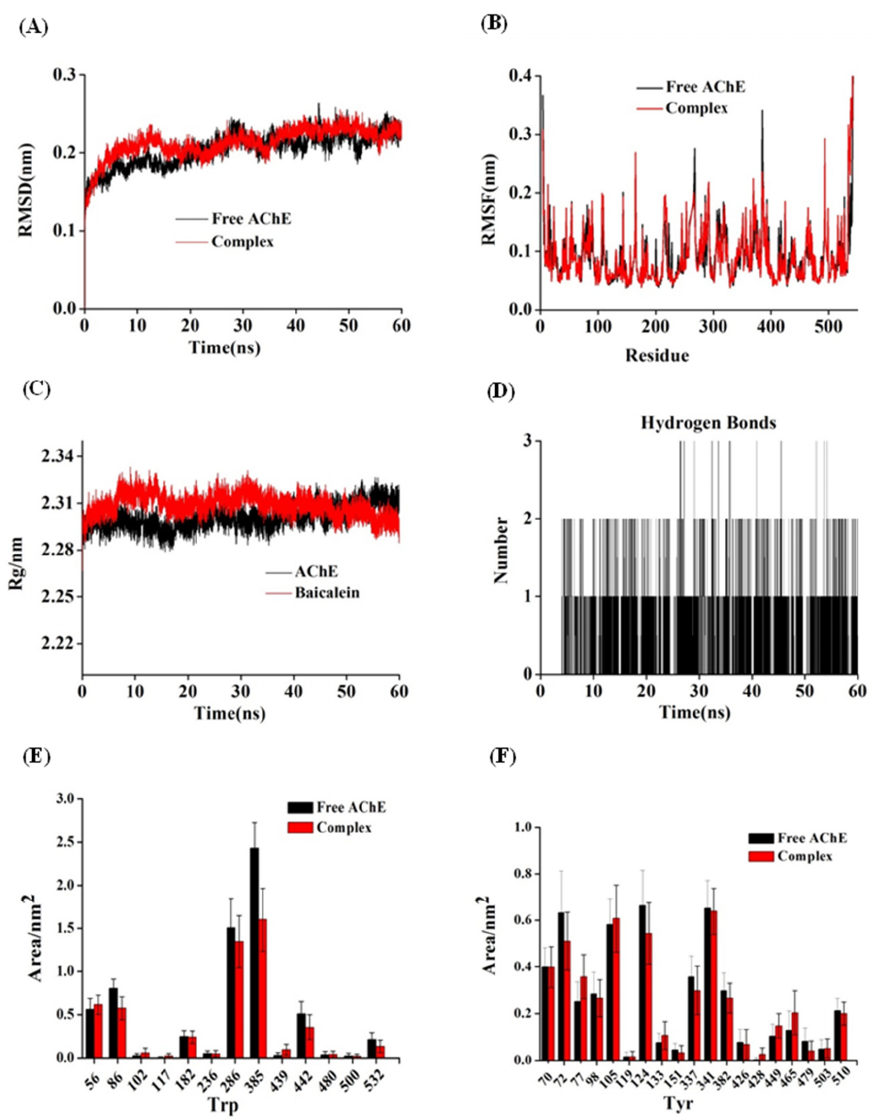
Figure 6. M.D. simulation of baicalein with AChE for 60 ns. The RMSD ( A ) and RMSF ( B ) plots, and Rg values ( C ) of the baicalein–AChE complex and free AChE backbone. ( D ) The number of hydrogen bonds between baicalein with AChE during simulation. The SASA values of the residues Trp ( E ) and Tyr ( F ).